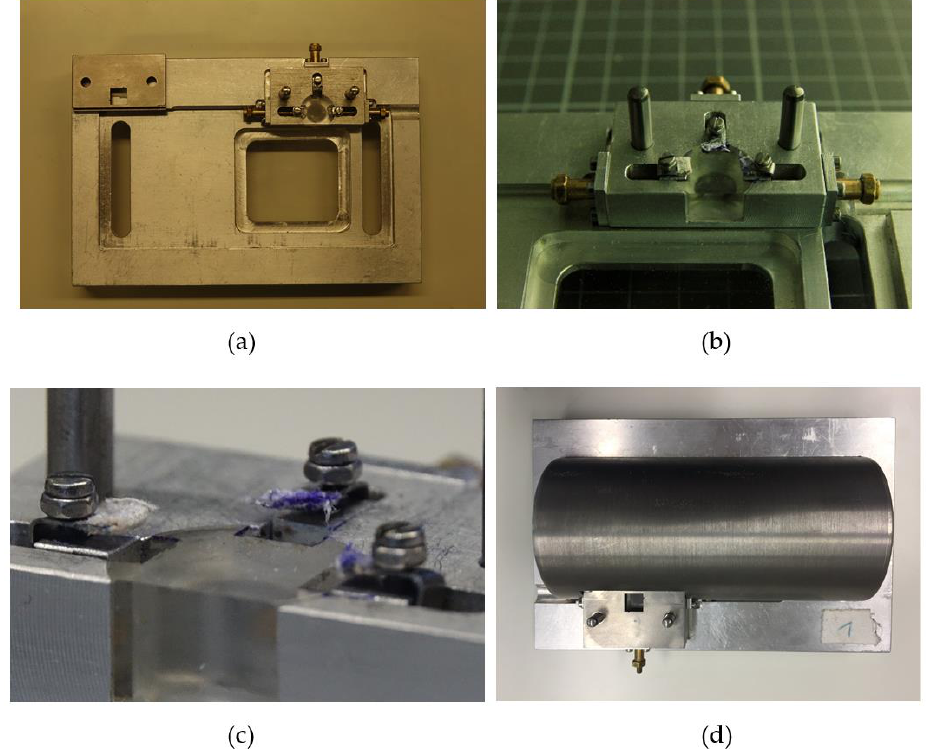
Figure 11. ( a ) Mouse ear holder for irradiation setup. ( b – c ) Three movable clamps can be seen directly next to the Plexiglas area on the top right corner with their corresponding golden millimeter screws. ( d ) The entire body of the mouse was shielded by a tungsten shield. Parts of the ear which were not irradiated were also shielded by a tungsten collimator.